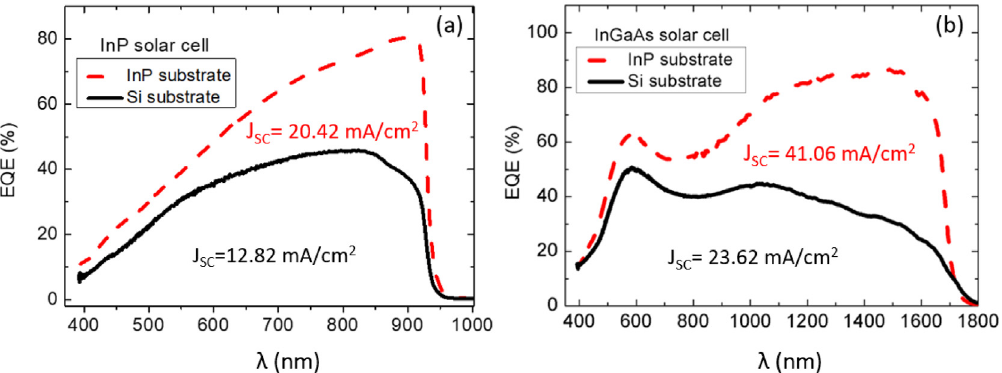
Fig. 11. EQE characteristic of the best InP (a) and InGaAs (b) Solar cells grown on Si template (black line), compared to the same result obtained on a typical InP substrate (dashed